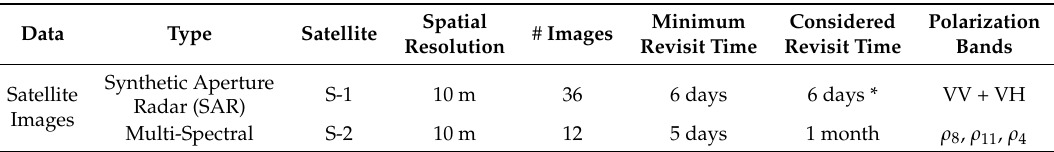
Table 1. Summary of the used satellite sensors. The * symbol indicates that we only considered 6 days revisit time around the considered S2 date.